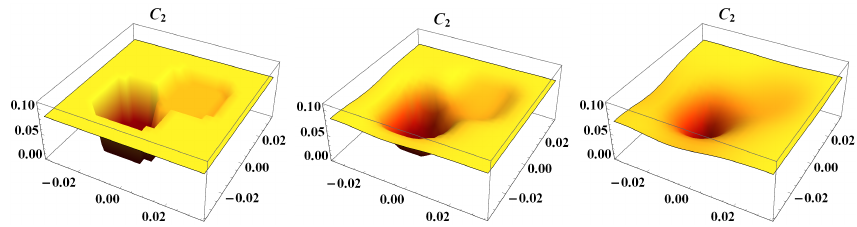
Figure 4. Distributions of Cu concentration c 2 for the times 0, 7 and 28 days